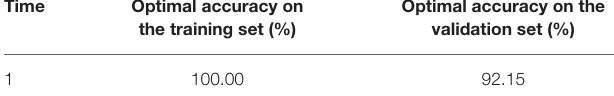
TABLE 2 | Model training results. Time Optimal accuracy on the training set (%)